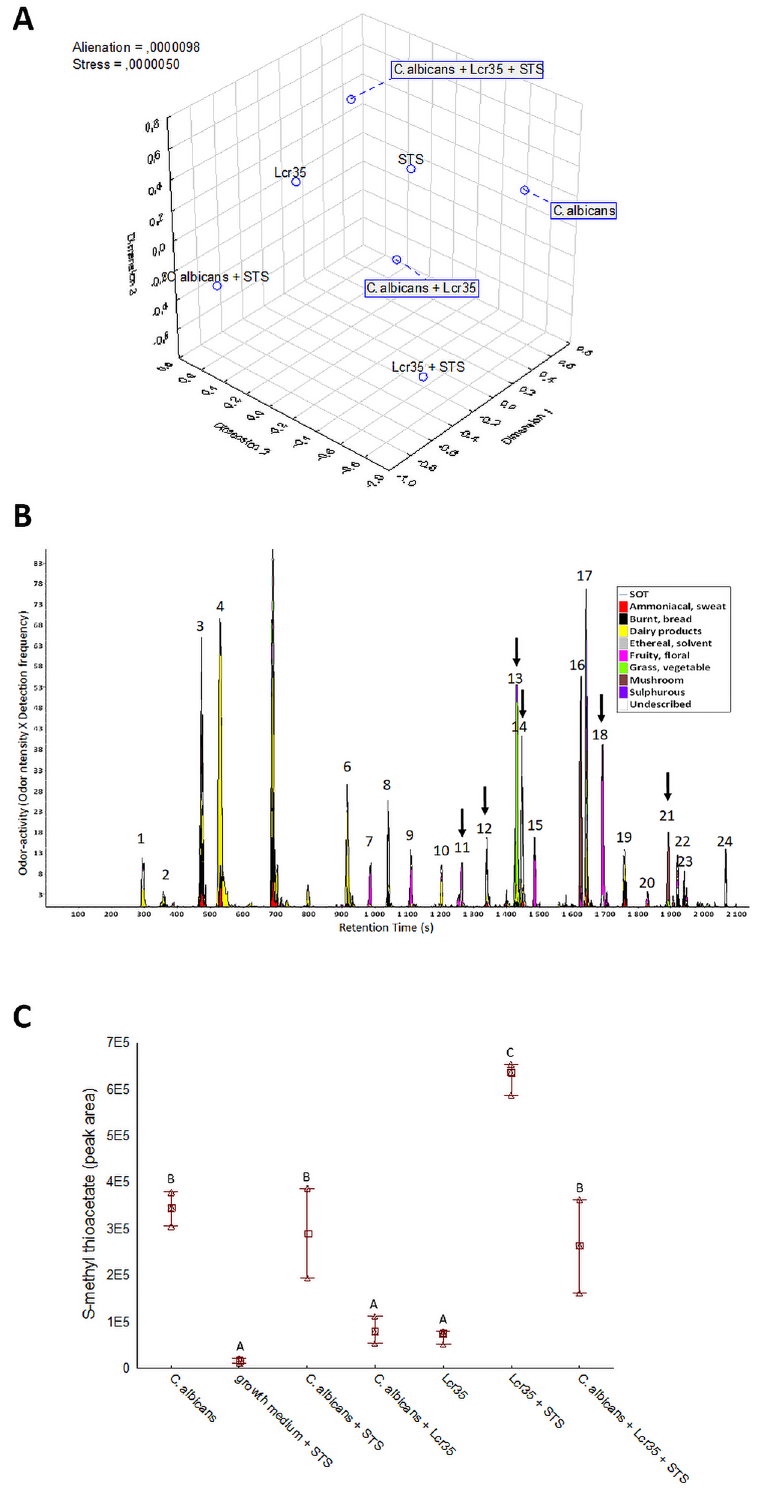
Figure 5. Odor dissimilarity-testing and volatolomic approach indicated the involvement of S-methyl thioacetate in the Lcr35 anti- Candida effect. Odor dissimilarities of seven conditions corresponding to culture media inoculated with C. albicans , Lcr35 and STS, alone or in combinations were assessed by non-verbal sensory evaluation thanks to 2D mapping (n = 25 assessors). Distance matrices were compiled and treated by MDS to determine the 3D representation of the odor dissimilarities ( a ). Odor-active compounds of the average of four conditions (Lcr35, C. albicans + Lcr35, Lcr35 + STS and C. albicans + Lcr35 + STS) were pooled in the aromagram profile ( b ). The peak numbers refer to odor-active compounds given in Table S4 (supporting information). Dark arrows indicate significant odor-active markers according to Kruskal–Wallis non-parametric test (p < 0.05). Abundance in S-methyl thioacetate ( c ) extracted after 12 h of incubation by GC–MS in the 7 conditions. Tukey multiple mean comparison test (p < 0.05) was performed on DH-GC–MS peak abundances—Means with the same letters (a–c) are not significantly